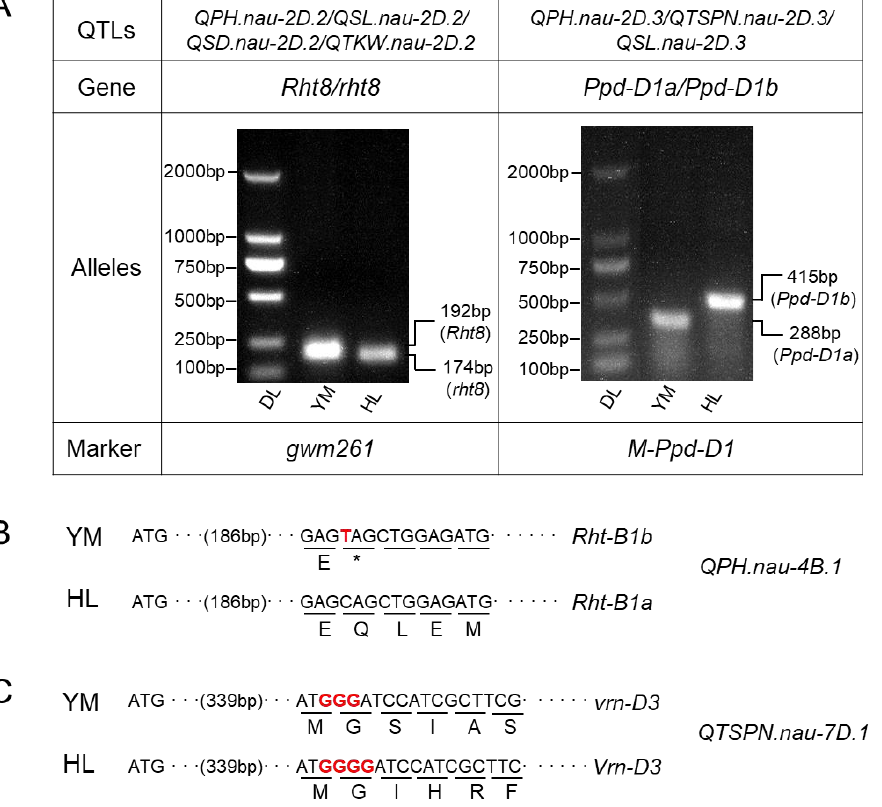
Figure 4. Allele composition of Rht8 , PPD-D1 ( A ), Rht-B1 ( B ) and Vrn-D3 ( C ) genes in YM and HL. YM: Yangmai158; HL: Triticum compactum Hiller; DL: DNA marker . The QTL QTSPN.nau-7D.1 was mapped to a 66.54 – 72.96 Mb interval, which encom- passed VRN-D3 ( FT-D ) on chromosome 7D (68.42 Mb). A 1-bp deletion was identified